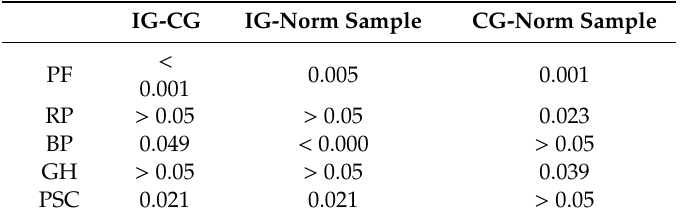
Figure 3. Baseline mean values of SF-36 outcomes for IG, CG and German norm data sample from 1994. Significant group differences are marked with asterisks. Subscales: physical functioning (PF), role limitations due to physical problems (RP), bodily pain (BP), general health perceptions (GH), vitality (VT), social functioning (SF), role limitations due to emotional problems (RE), mental health (MH) and physical and mental health sum scores (PSC and MSC, respectively). Significant differences are marked with asterisks (“*” = p < 0.05; “**” = p < 0.01; “***” = p < 0.001). Table 2. p -Values for baseline data di ff erences of IG, CG and the German norm data sample from 1994 for significant SF-36 outcomes PF, RP, BP, MH and PSC. Bonferroni–Holm correction for multiple comparisons has been